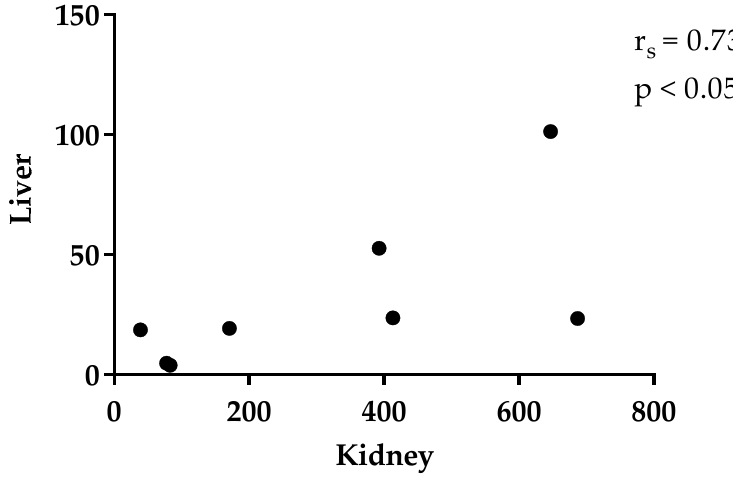
Figure 3. Correlation between liver and kidney (ng/g DM). Table 3. Thymol content in caecum, colon, and faeces (ng/g DM). Table 2. Thymol content in plasma (ng/mL) and tissue (ng/g DM). 56 d of Age (with Thymol) 63 d of Age (without Thymol)